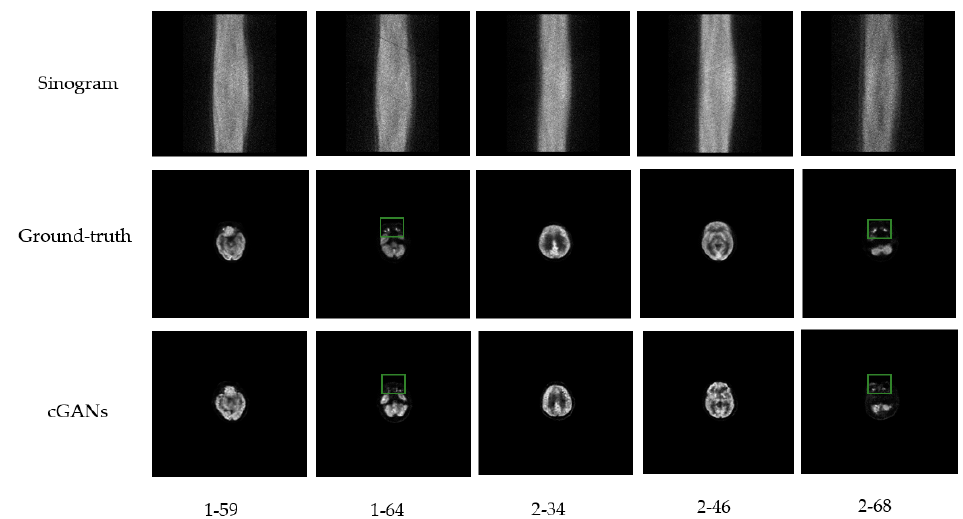
15 of 18 Ground Truth Figure 13. Reconstruction results of different slices of SD rats. From top to bottom: sinogram images, ground truth (OSEM), reconstruction results of cGANs. 4.3. Real Patient Experiments Several different learning rates and epochs were applied to a real human brain da- taset. The best results were obtained with lr = 0.002 and 120 epochs. The training dataset contained seven objects, including 651 image pairs. The testing dataset contained two ob- jects, which included 186 image pairs. Finally, five slices were selected from the test da- taset, as shown in Figure 14. The quantitative results, including the SSIM and rRMSE, are shown in Figure 15. Compared to the SD rat whole-body dataset, the human brain dataset obtained better results in terms of reconstructed image quality. The SSIM of the test im- ages was close to 0.94. The mean rRMSE was approximately 2.74. It is considered that the whole-body dataset of the SD rats may have finer and more complex structures than the human brain dataset. However, for a detailed structure, such as the green rectangle in